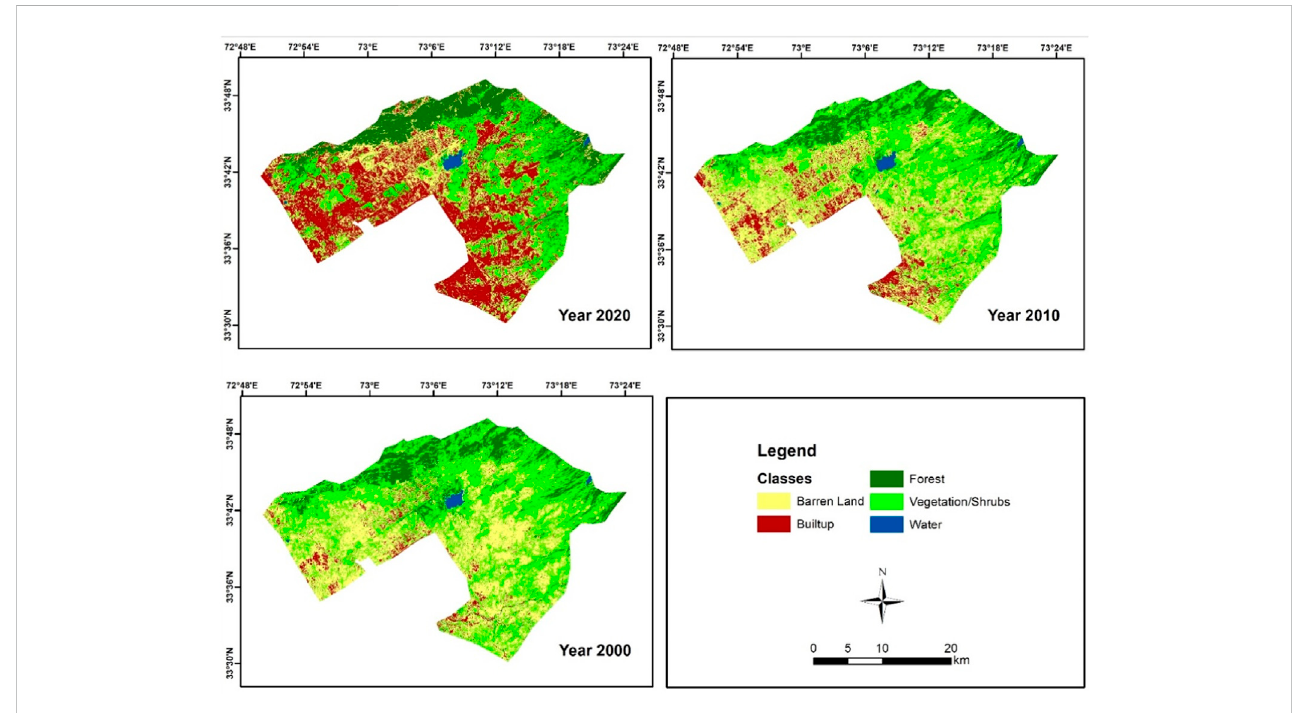
FIGURE 4 Comparison of LULC classi fi cation map of Islamabad, 2000, 2010, and 2020.